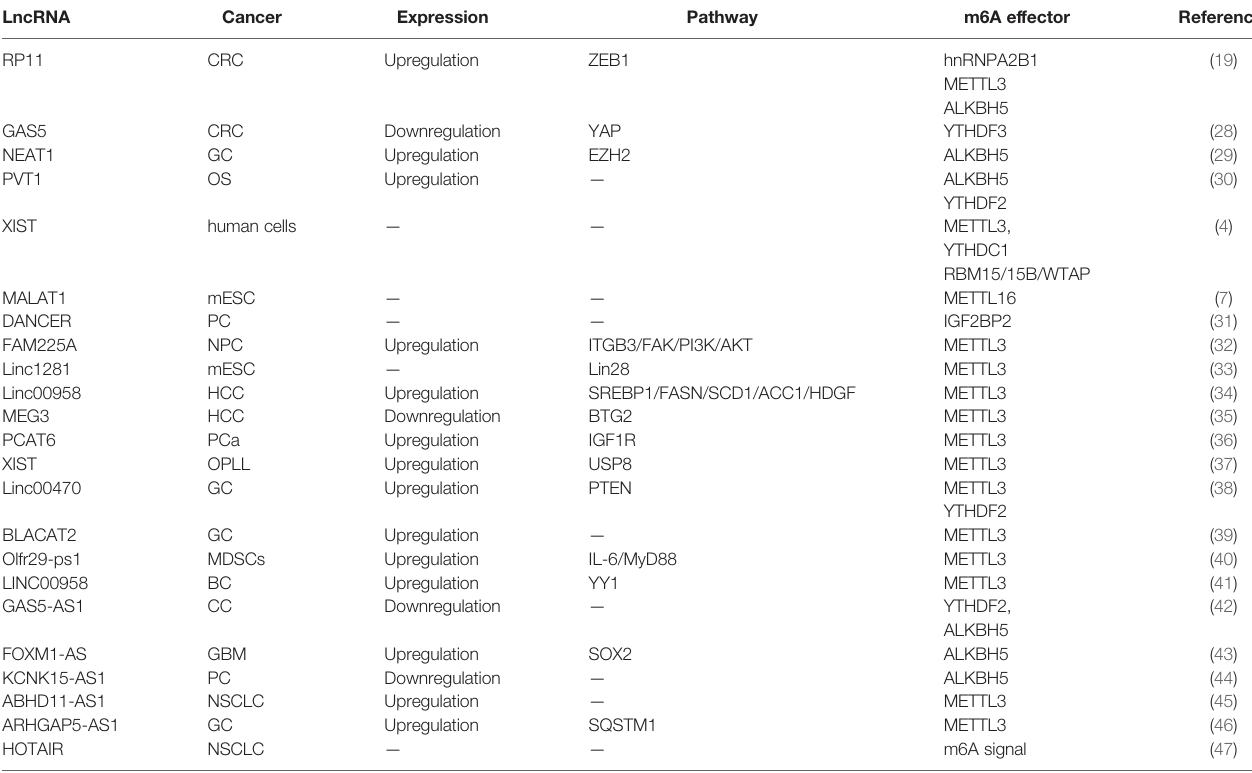
TABLE 1 | LncRNAs in disease or normal cells and related m6A effectors. LncRNA